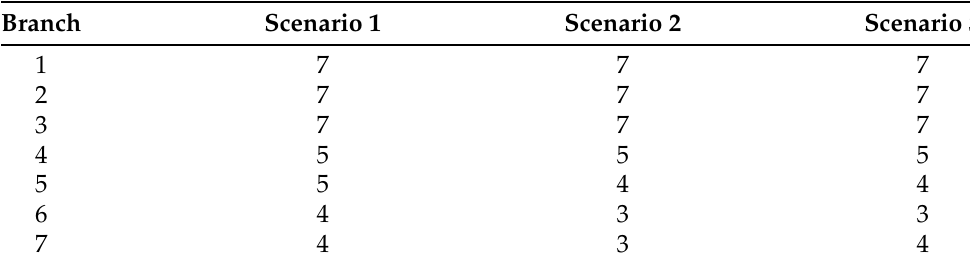
Table 17. Conductor selection test system